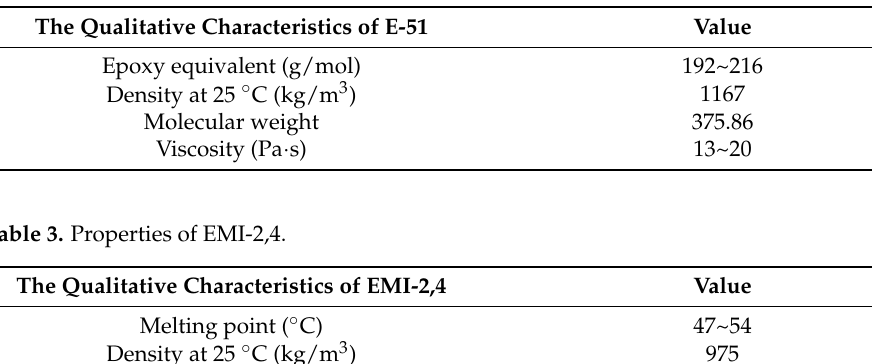
Table 2. Properties of epoxy resin E-51.